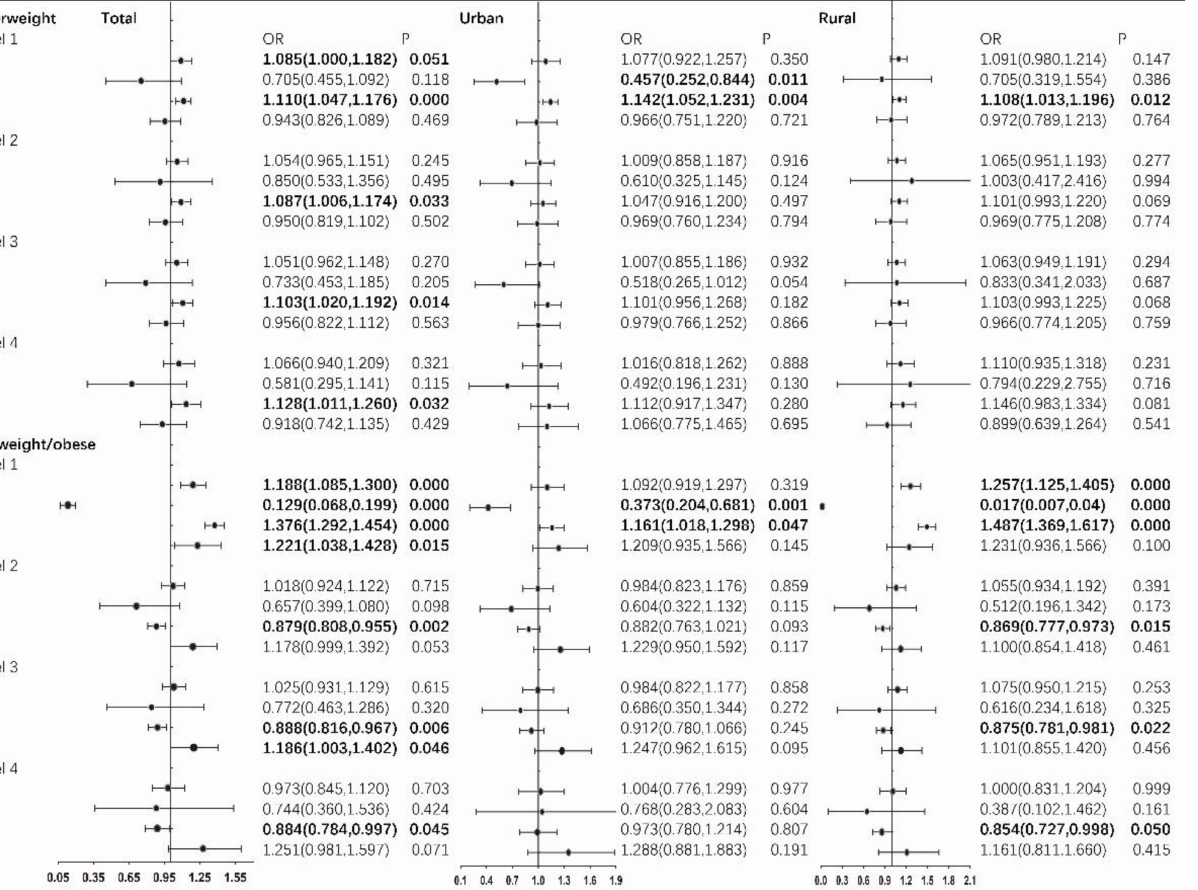
Figure 5. Longitudinal estimations of the odds ratios of being underweight and the odds ratios of being overweight/obese for the total, urban and rural children. Note: 1. Model 1: Social